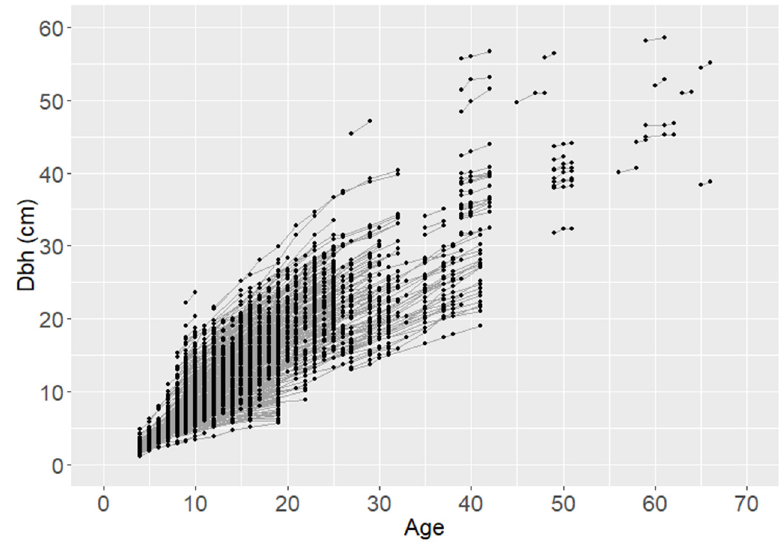
Figure 3. Temporal variation of target tree dbh (trees from the control plots not included). The gray lines connect the successive measurements of a tree.